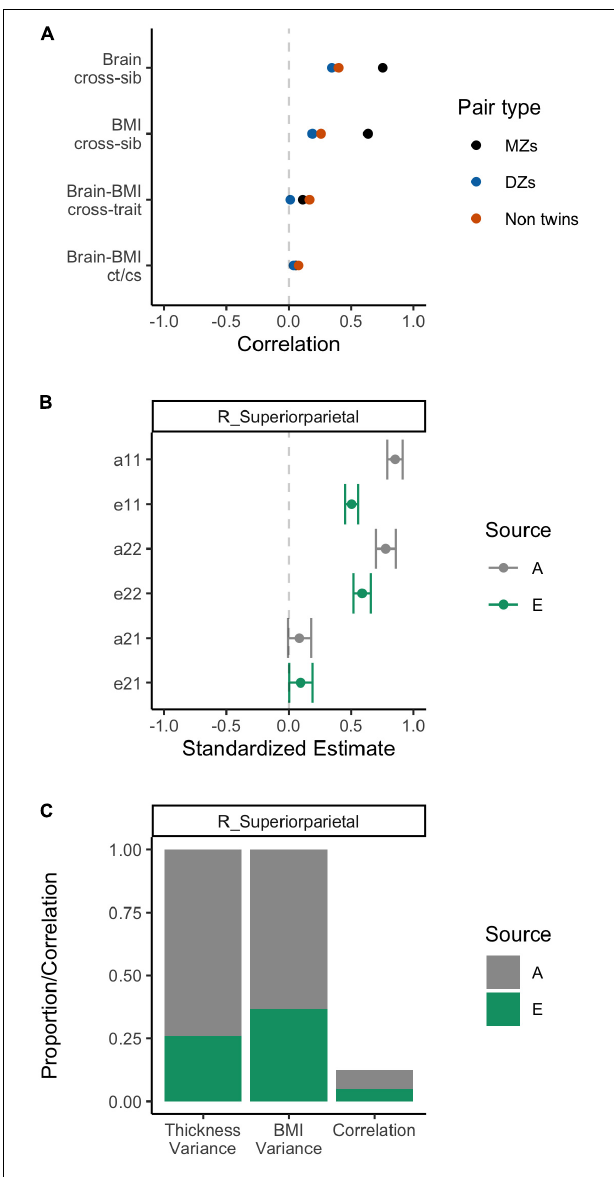
FIGURE 7 | Summary of behavioral genetic analyses of body mass index and right superior parietal thickness, including cross-sibling, cross trait correlations (A) , path estimates from AE bivariate model (B) , and variance and correlation components from AE bivariate model (C)